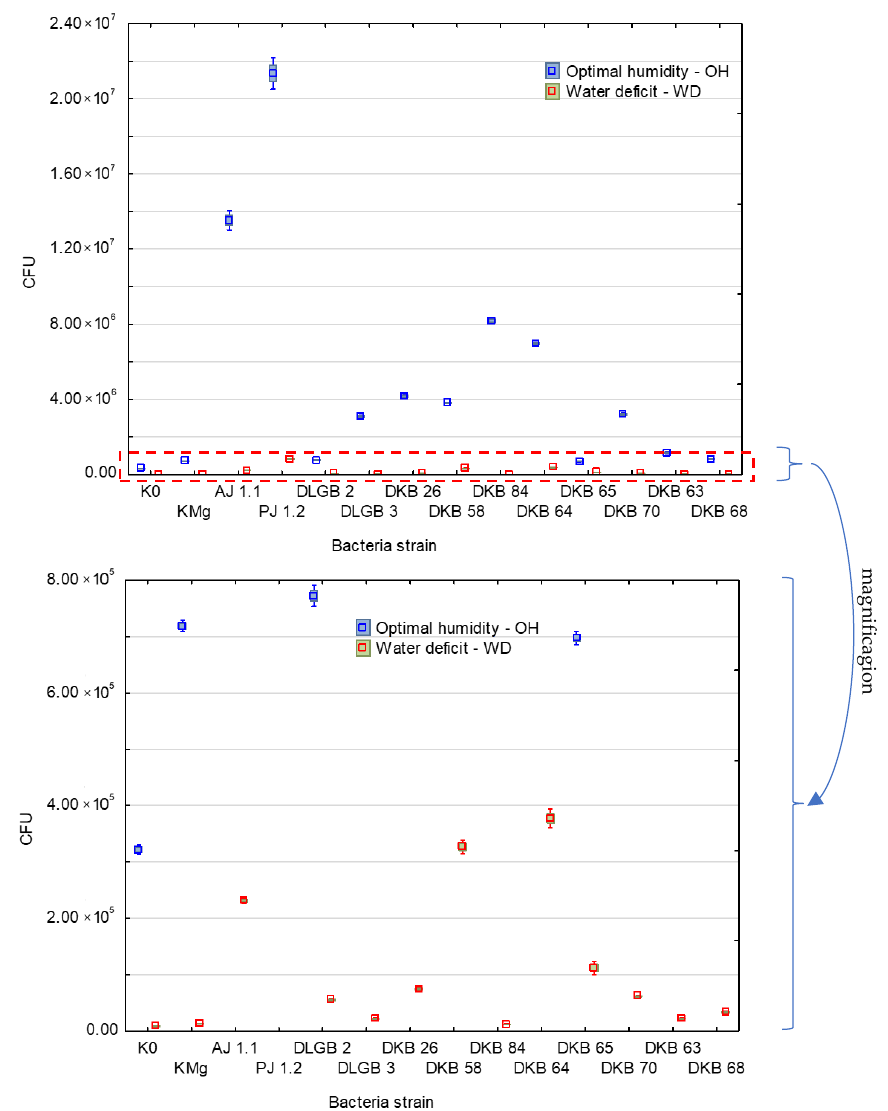
Figure 1. Bacterial counts in growth substrate after inoculation with rhizosphere bacteria under different levels of substrate moisture.